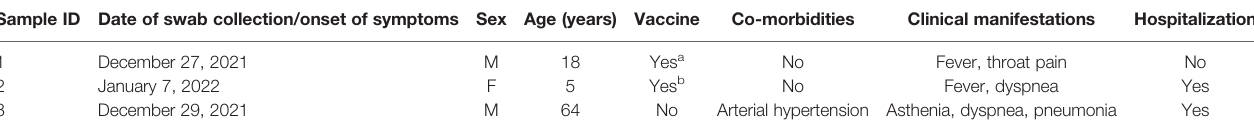
TABLE 1 | Main characteristics of the patients with SARS-CoV-2 Delta/Omicron co-infections. Sample ID Date of swab collection/onset of symptoms Sex Age (years)